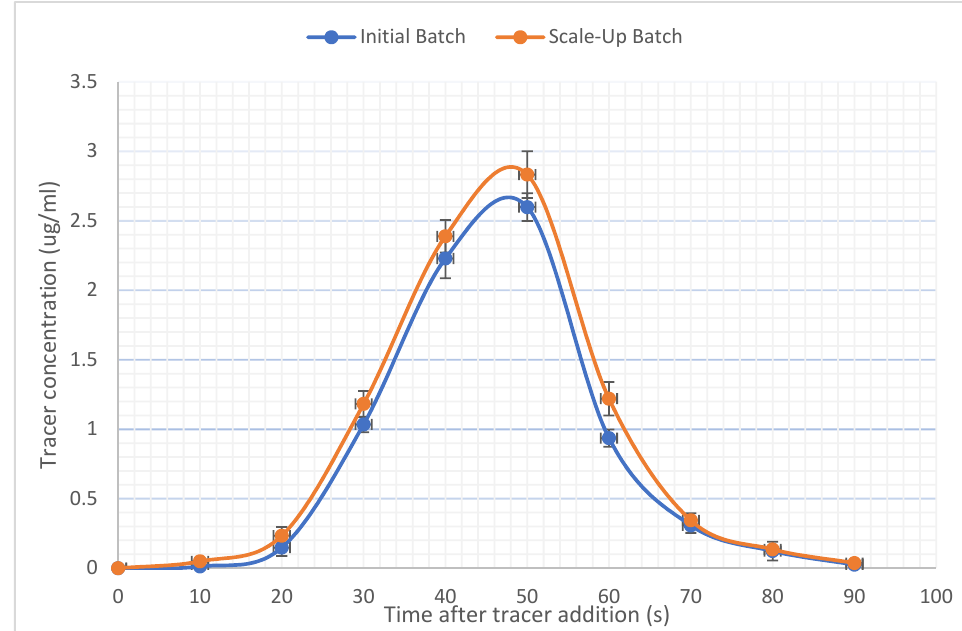
Figure 1. The graph shows the residence time distribution (RTD) of the initial (F3) and scaled-up (F6) batches derived by using the following equations [44,45].